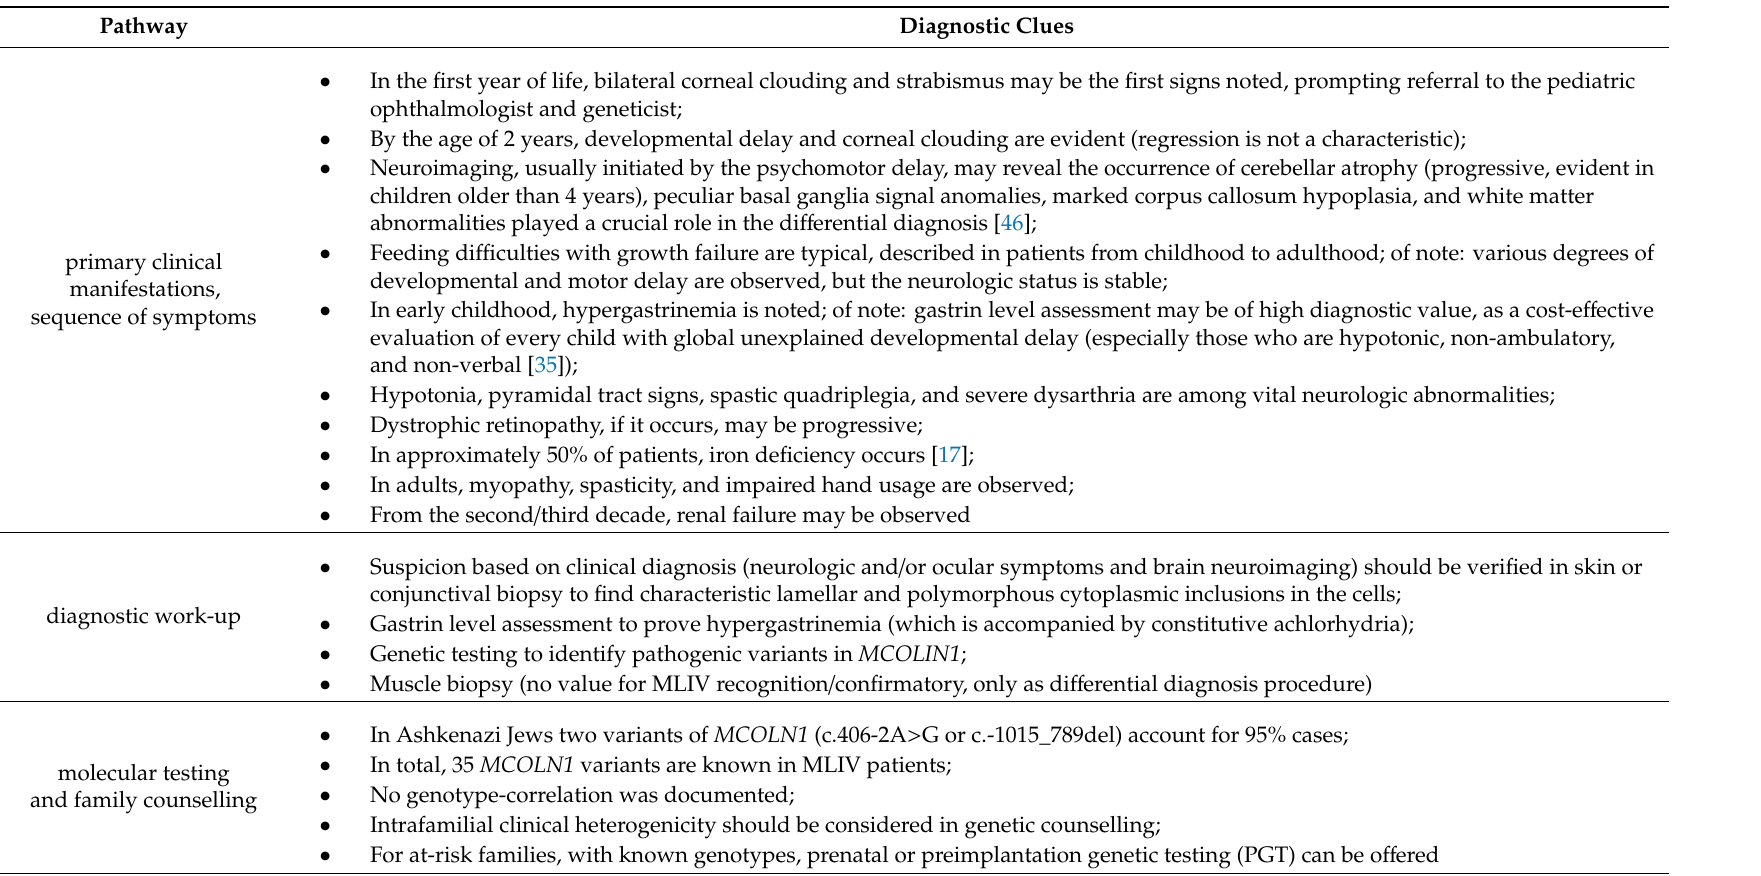
Table 2. Diagnostic pathway of